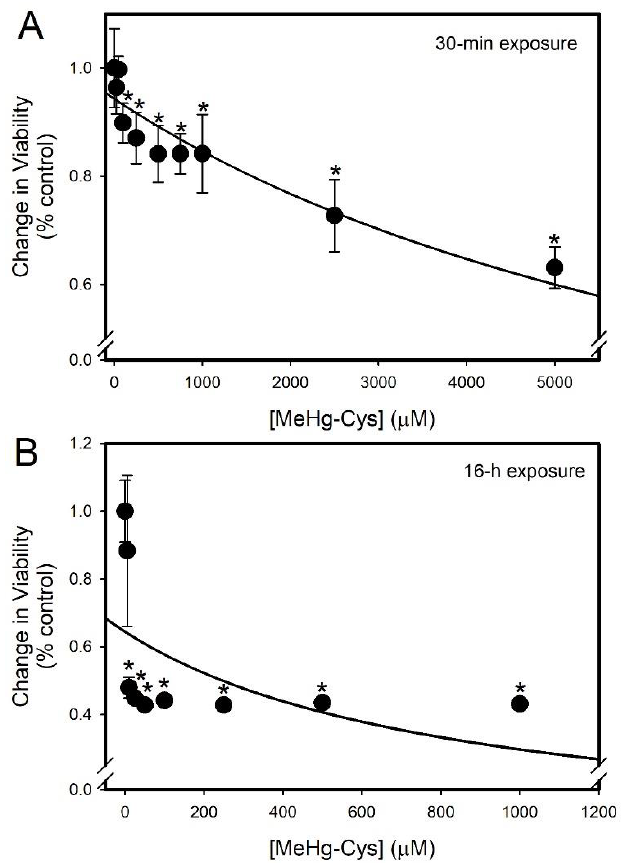
Figure 4. Cellular viability of BeWo cells exposed to MeHg-Cys. BeWo cells were exposed to various concentrations of MeHg-Cys for 30 min ( A ) or 16 h ( B ) at 37 °C and cell viability was measured using a methylthiazoletetrazolium (MTT) assay. The concentration of MeHg-Cys was reduced for the 16 h exposure because higher concentrations resulted in overt cell death. Results are presented as mean ± SE. Data represent 3 experiments performed in triplicate. *, significantly different ( p < 0.05) from unexposed cells.